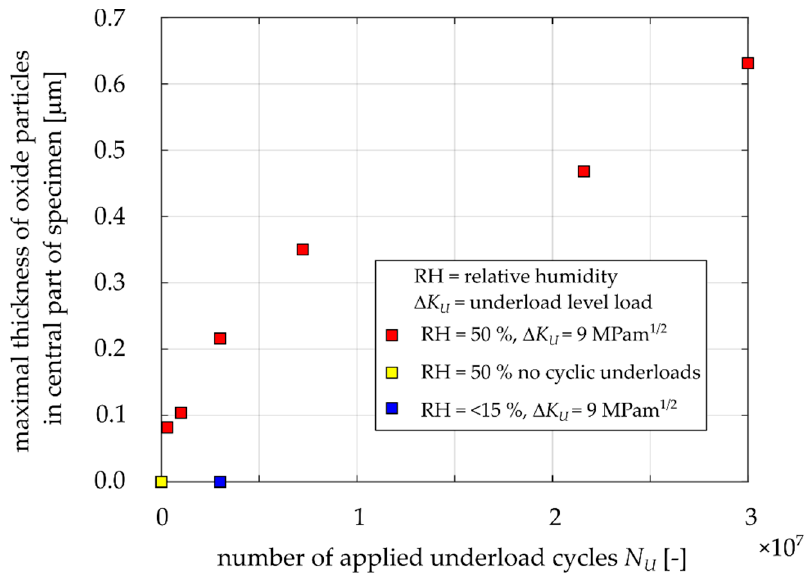
Figure 17. Measured thicknesses of the oxide layers for Specimens 3, 4, 7, 8, 10, 11, 12, 14, 15 and 16 based on the FIB cuts imaging.